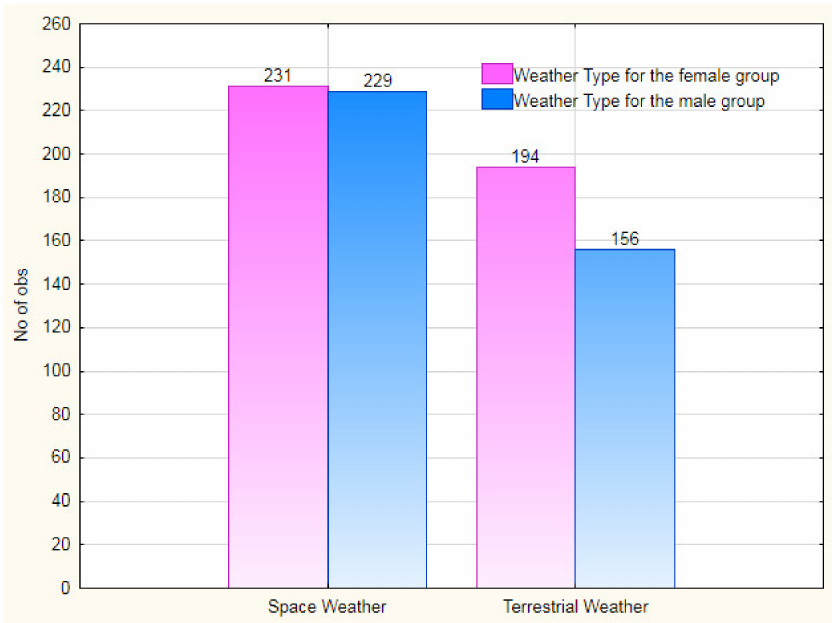
Figure 5. The ratio between Space Weather and Terrestrial Weather characteristics, which have differed when corresponding to different medical events in all Maximal Difference Days of 15 calendar seasons. Alternative gender groups from the medical call logs of ischemia